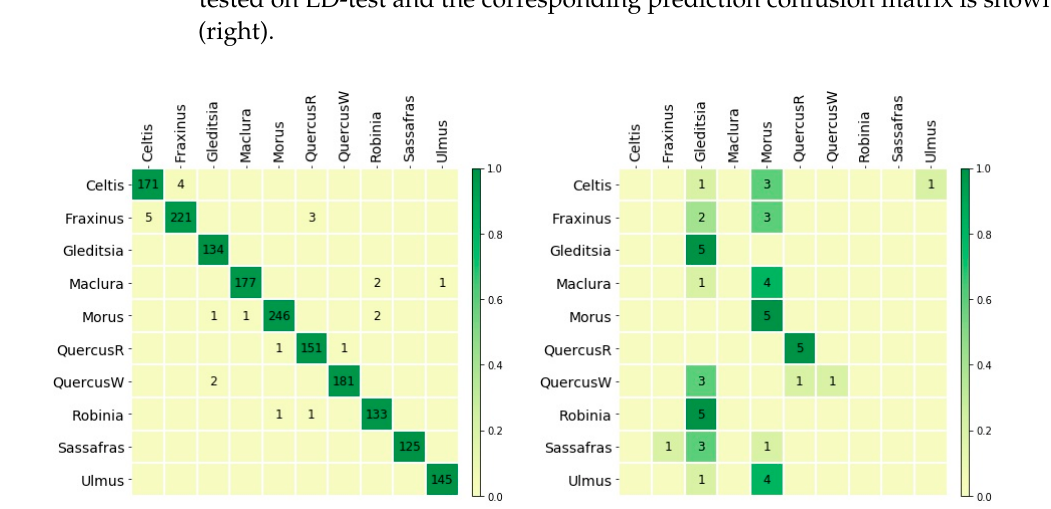
Figure 4. Confusion matrices for models trained on LD-train. ( Left ) Image-level confusion matrix for LD5. The confusion matrix, and accuracy (98.5%), were obtained by aggregating over the five cross-validation folds. ( Right ) specimen-level confusion matrix for LDF on LD-test images with an accuracy of 32.0%. The only classes with correct predictions were Gleditsia, Morus, QuercusR, and QuercusW. Evaluation of models trained on XT-train : The image and specimen level prediction confusion matrices for XT5 and XTF are provided in Figure 5. The predictive accuracy metrics for all the trained models are summarized in Table 3.